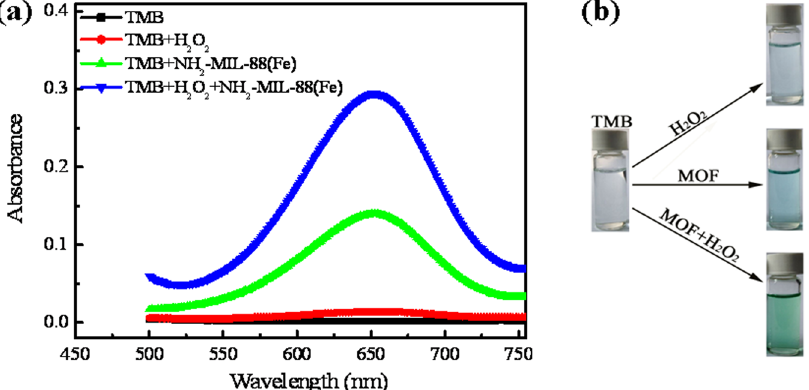
Figure 2. ( a ) UV/vis spectroscopy of 0.05 mM TMB after 20-min reaction with and without 0.1 mM H 2 O 2 in 0.2 M acetate buffer (pH 4.0) in the absence and presence of 40 mg/L NH 2 -MIL-88B(Fe). ( b ) Images colour reaction of TMB oxidation by H 2 O 2 or dissolved O 2 in the absence and presence of NH 2 -MIL-88B(Fe).